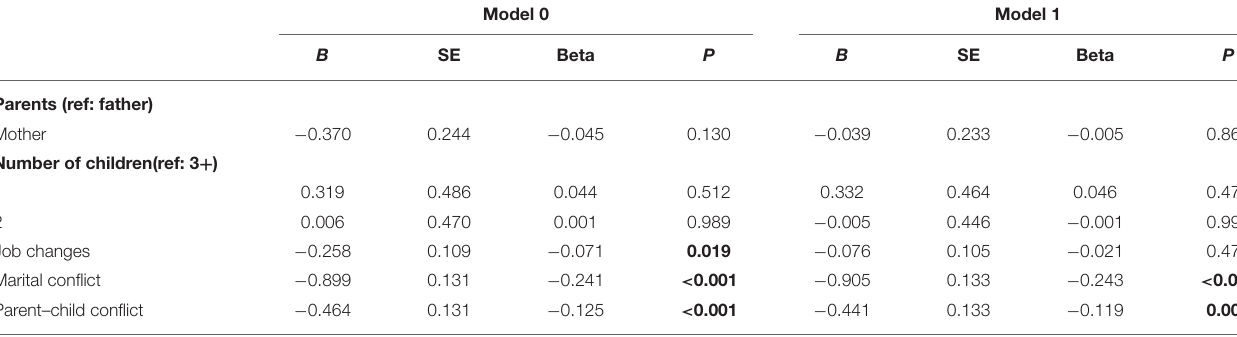
TABLE 2 | The relationship between job changes, family conflicts, and quality of